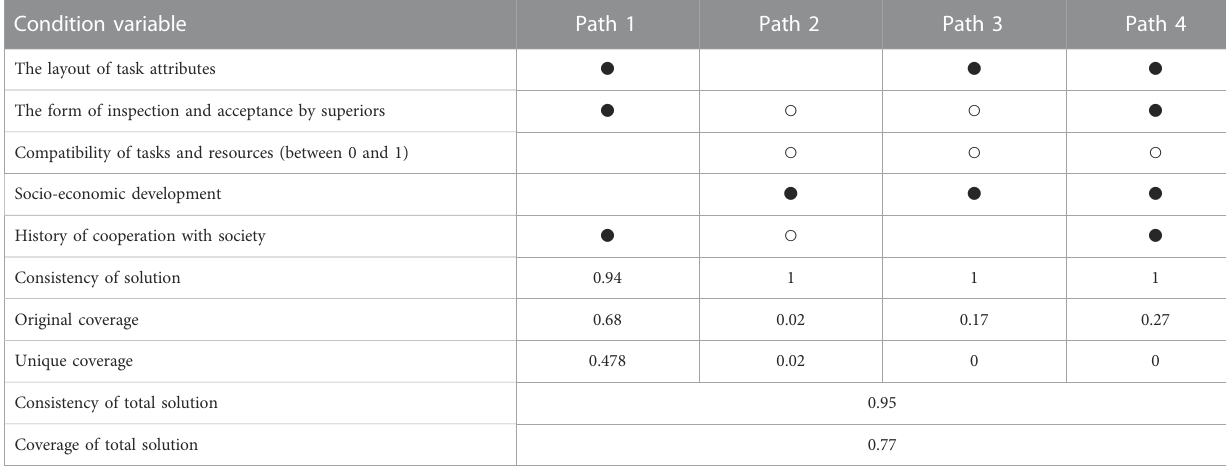
TABLE 3 Analysis of Conditional Combination with “ downward cooperation ” (cooperating with the public) as the dependent variable. Condition